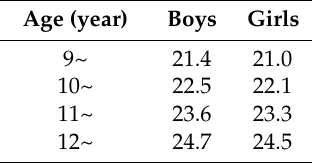
Table 1. Body mass index reference norm for screening obesity in Chinese children and adolescents [21].